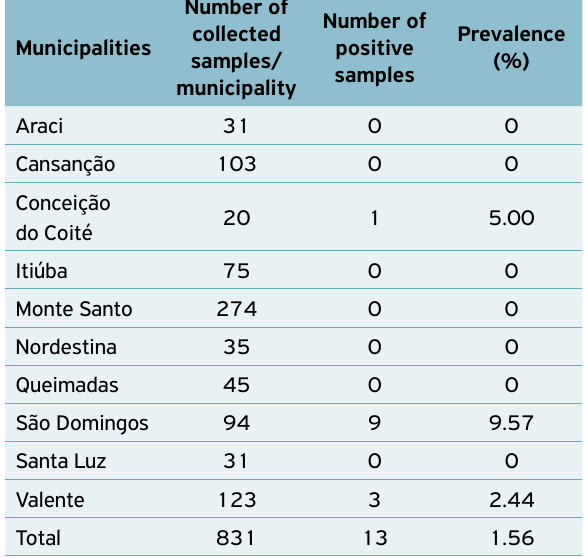
1. Serological prevalence of caprine arthritis